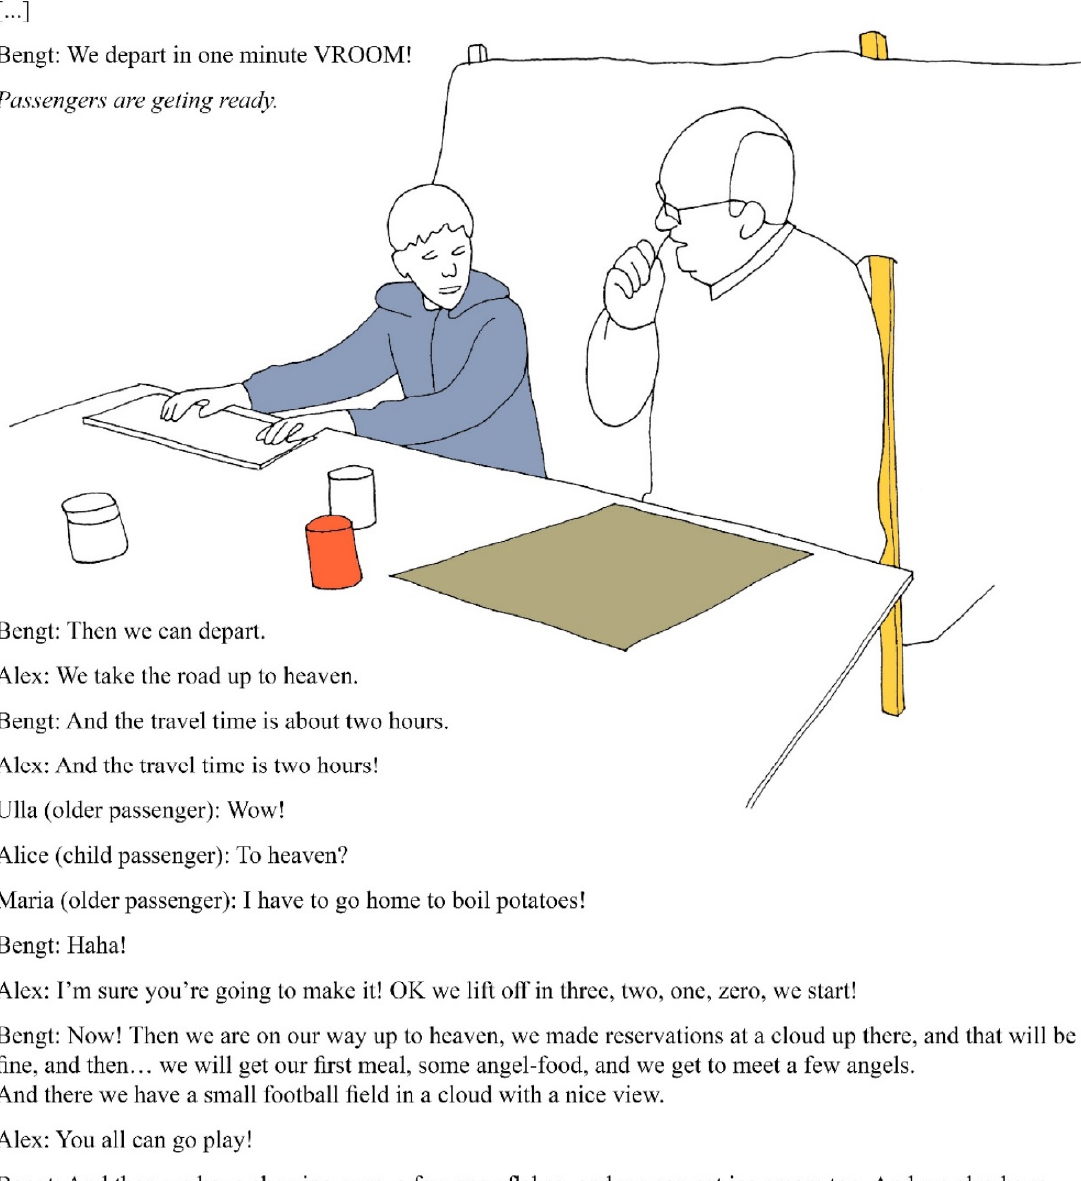
Figure 2. Traveling to after life (illustration by author MK, based on a photograph of the workshop).